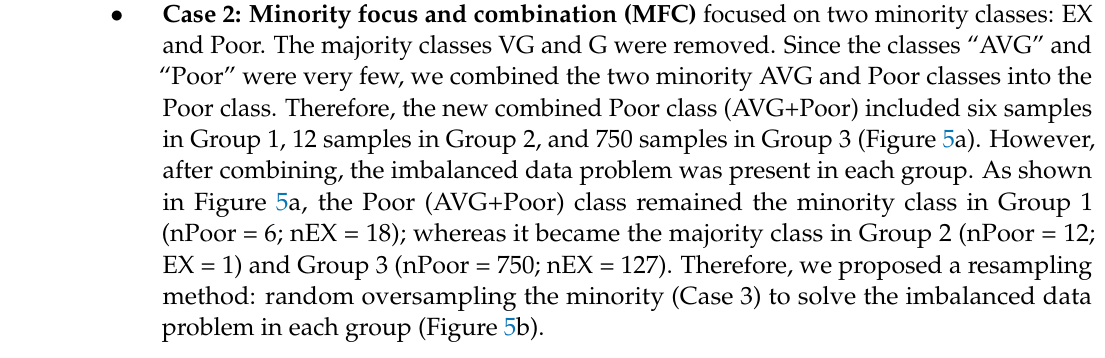
Figure 4. Numbers of samples in each group in Case 1: Origin.